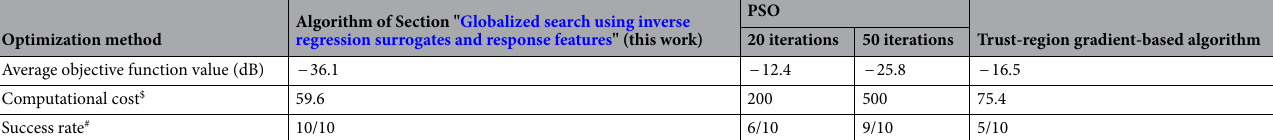
Algorithm of Section "Globalized search using inverse regression surrogates and response features" (this